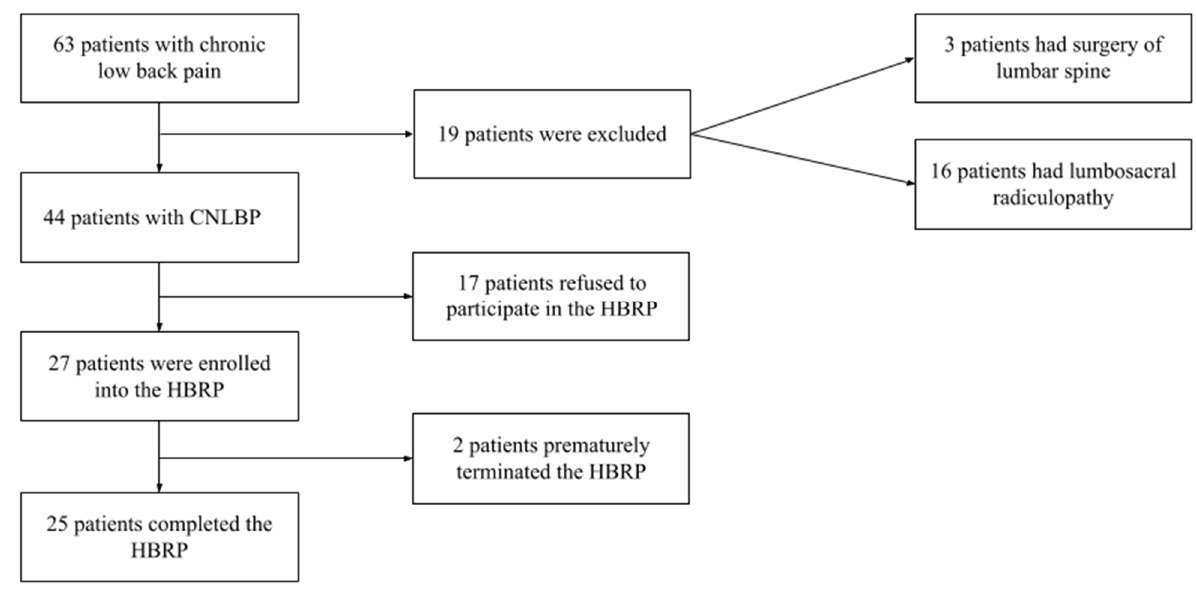
Figure 2. Study flowchart, including subject recruitment. Table 1. Characteristics of subjects.